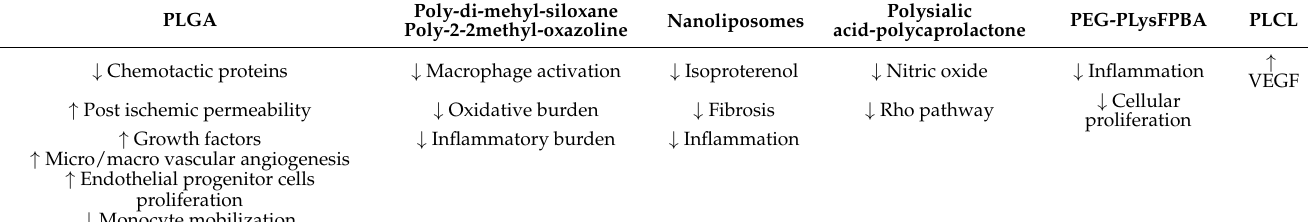
Table 4. Summary of the effect of currently available statin-loaded nanoparticles.